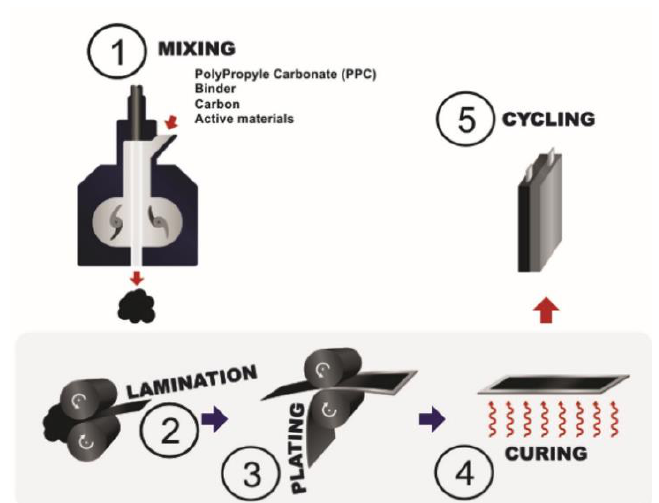
Figure 9. The different steps of the extrusion process developed by El Khakani et al. to formulate Li-ion battery electrodes. Reprinted with permission of Journal of Power Sources 454, 2020, 227884 [87].